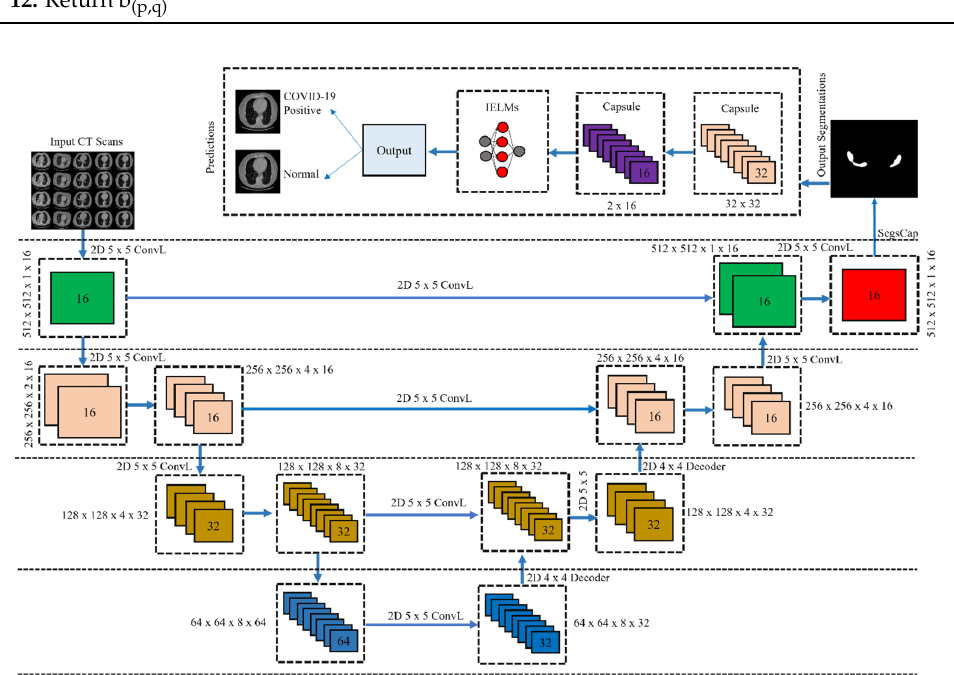
Figure 3 . Proposed CapsNet with IELMs